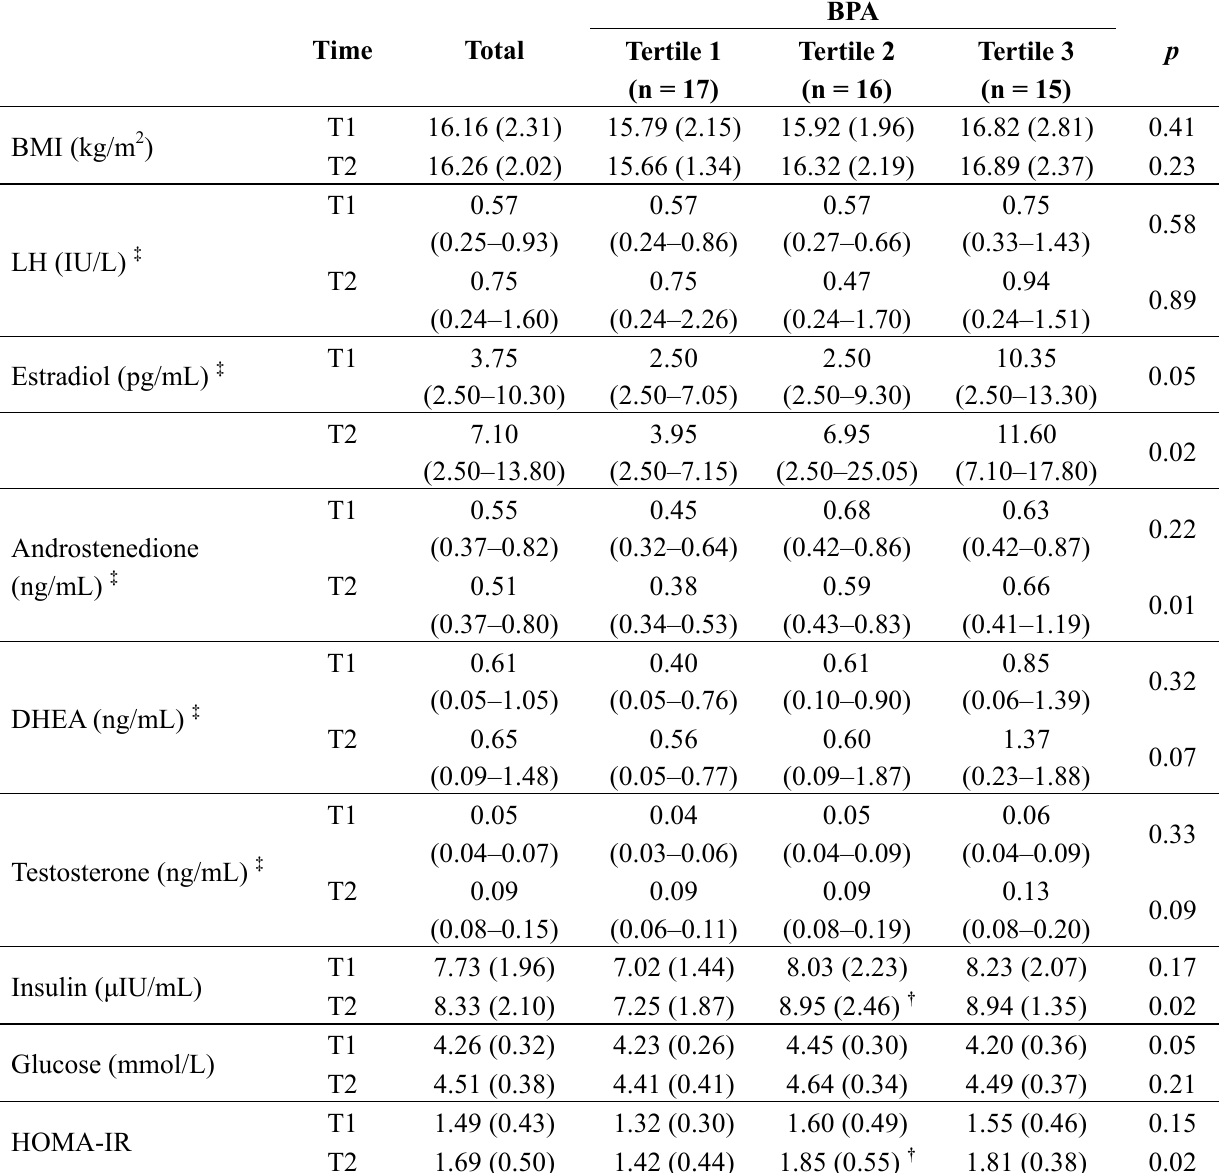
Table 3. Comparison of sex hormone levels and metabolic indices at different time points according to urinary bisphenol A